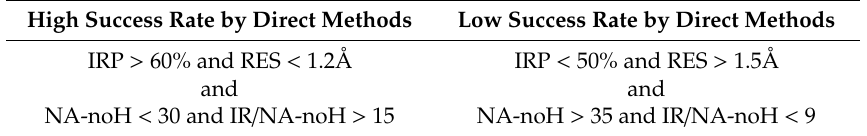
Table 2. Conditions for high and low success rates of structure solutions by Direct Methods.